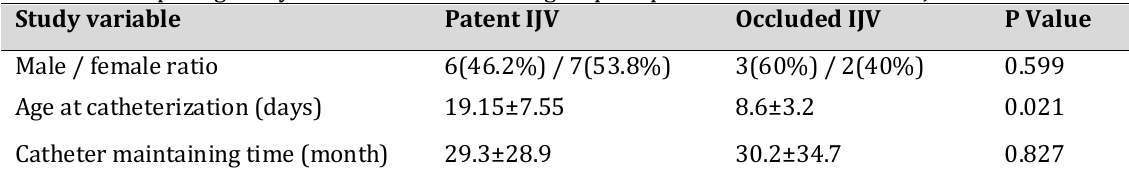
Table 1: comparing study variables between two groups of patients with or without IJV Occlusion Study